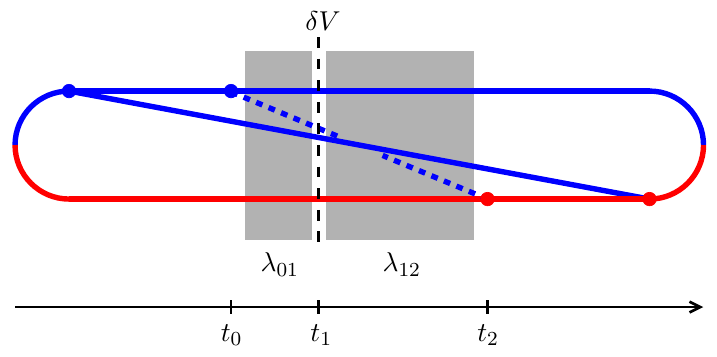
Figure 13 . Like figure 12 except with only one insertion of δV (or δ 2 V ) during the 4-particle time